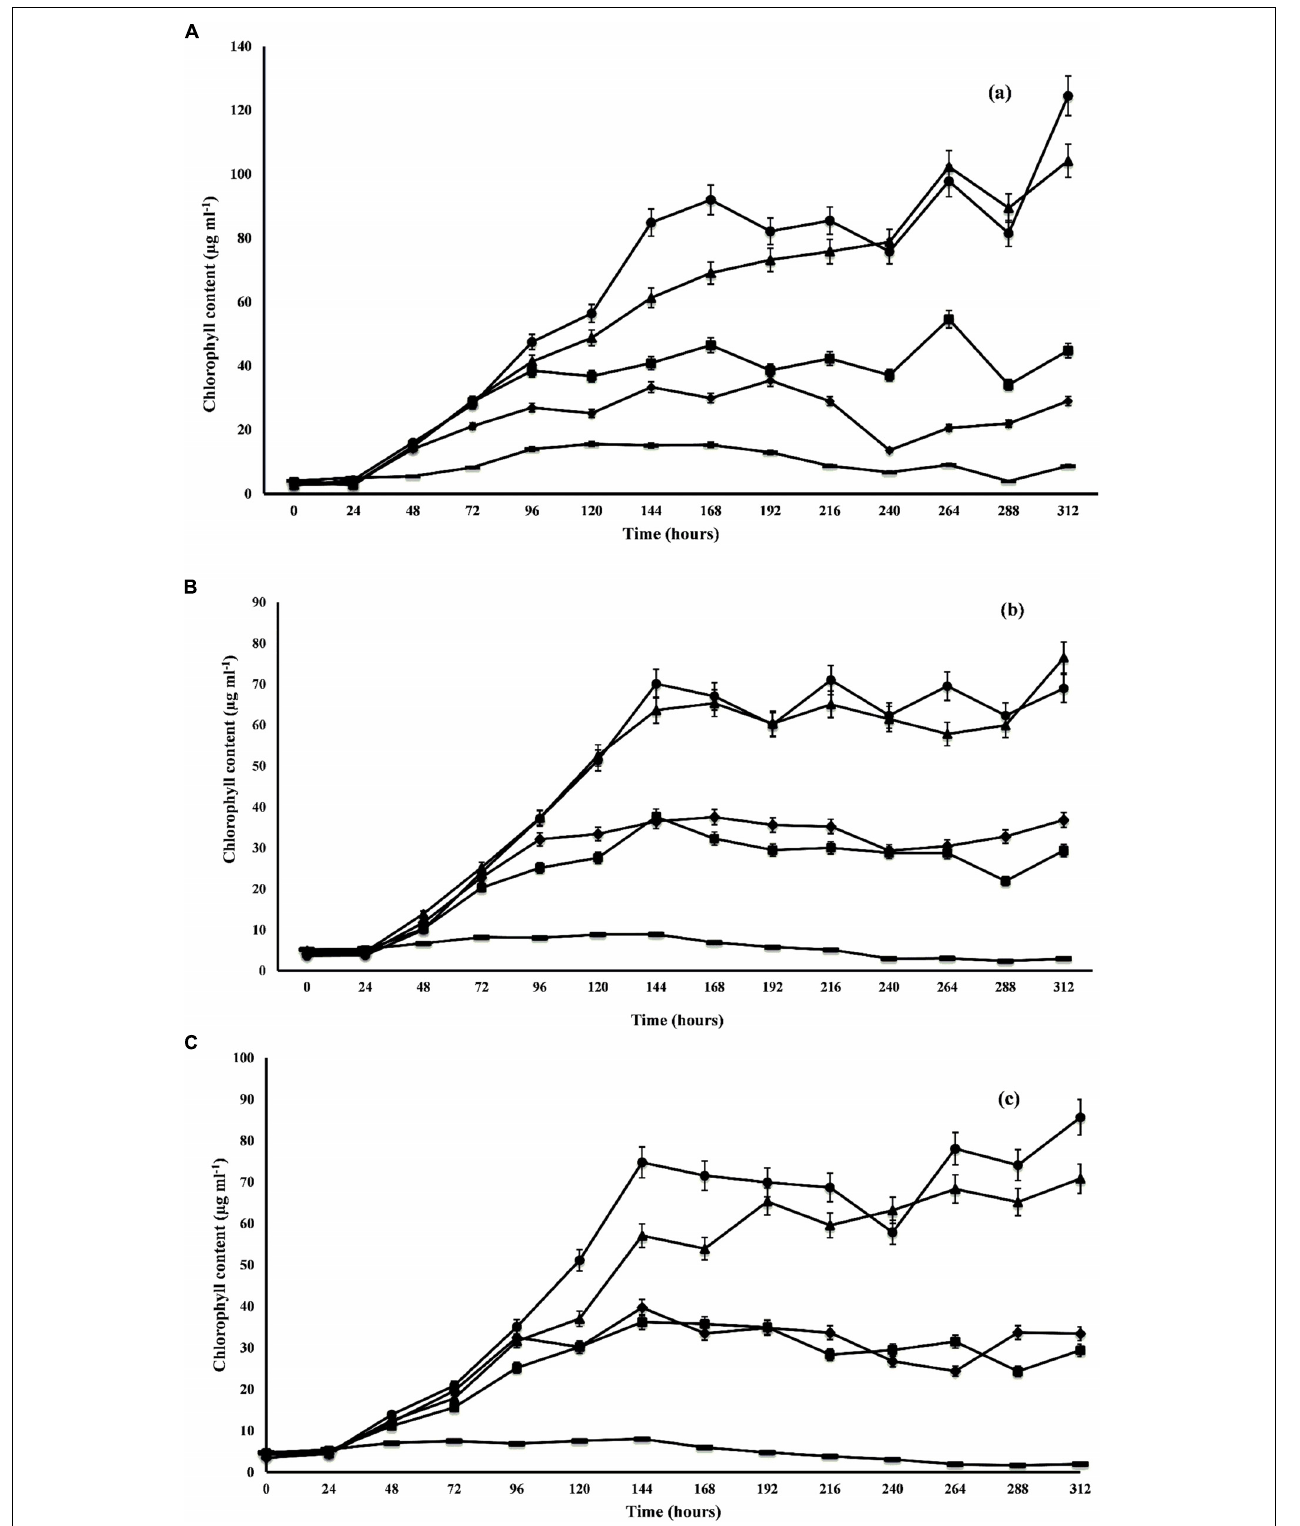
FIGURE 1 | Growth profile of C. pyrenoidosa (A) , S. abundans (B) , and A. ambigua (C) at different ratios of DWW and standard growth medium (control; (cid:4) 1:3 DWW; (cid:78) 1:1 DWW; 3:1DWW; (cid:7) 1:0 DWW) (Values represent the mean ± SD of three